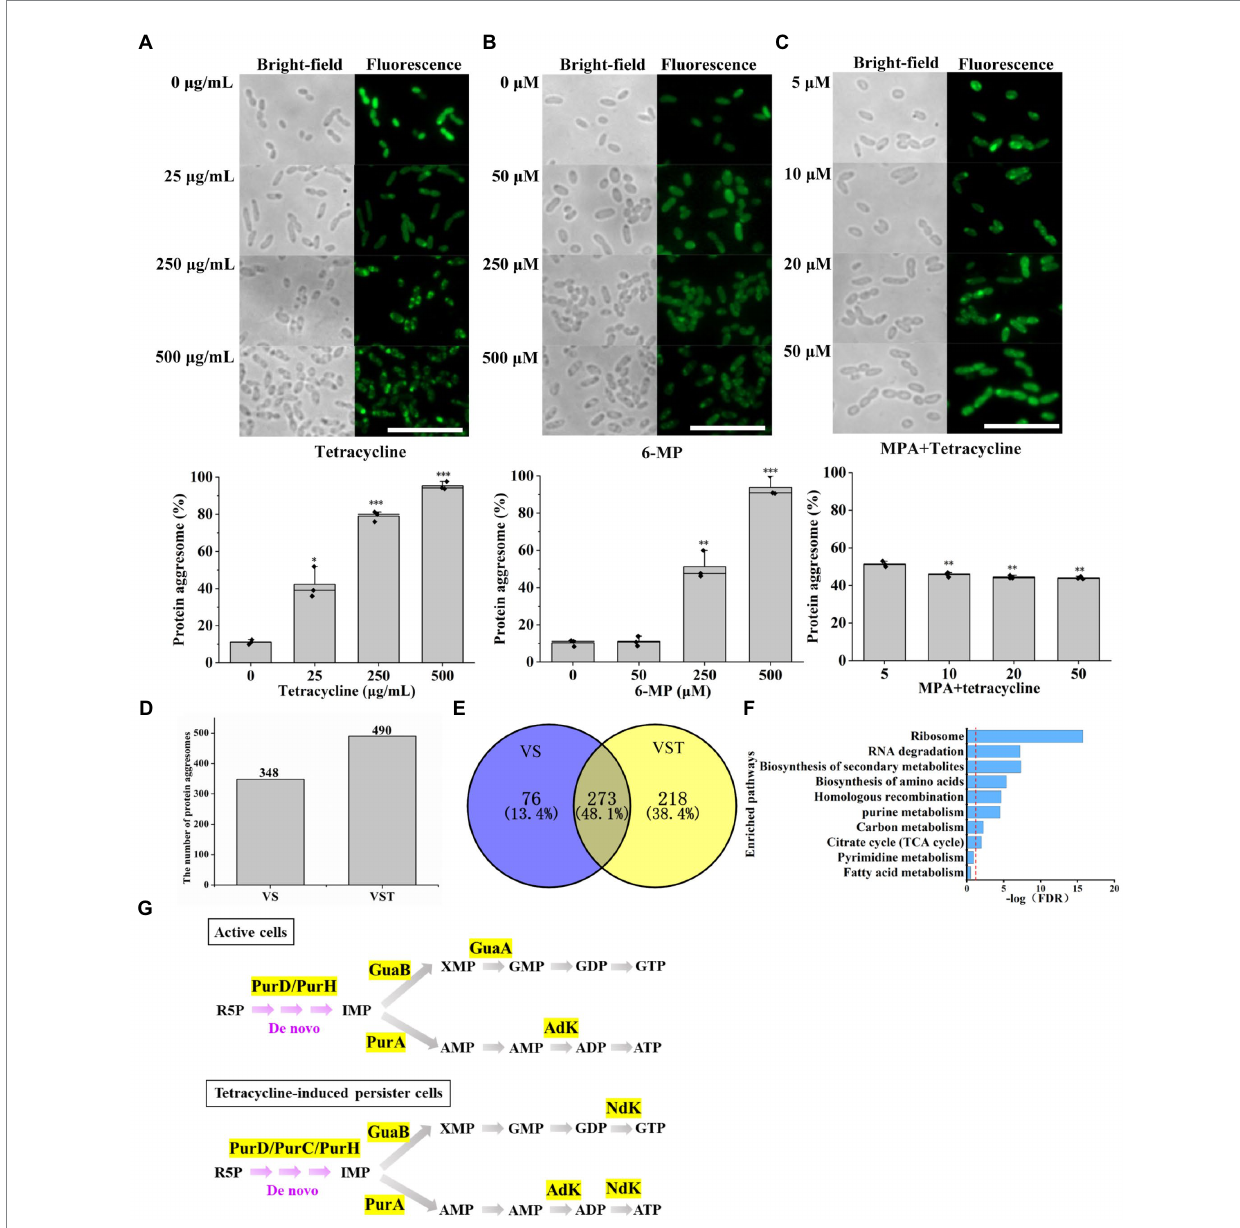
FIGURE 3 Decreased purine metabolism accompanies protein aggresome formation. Bright-field and fluorescence images showing that protein aggresomes are induced by different concentrations of tetracycline (A) or 6-MP (B) . And percentage of cells with protein aggresome after different concentrations of tetracycline treatment or 6-MP. On contrast, MPA exposure (C) significantly depressed the protein aggresome intensity. Protein aggresome from and tetracycline-induced persister cell and active cells were characterized by mass-spectrometric analysis (D) . (E) Venn diagram showing the insoluble protein overlap in active cells and tetracycline-induced persister cells. Further KEGG analysis revealed that 273 common proteins were involved in several important biological processes, in which purine metabolism related proteins were showed in (F) . (G) Purine metabolism-related proteins were found in protein aggresomes of tetracycline-induced persister cells and active cells. The scale bar of the figure was 10 μ M. The bars indicated the mean of percentage of cells with protein aggresome in cell of different treatment at least three independent experiments; standard deviation indicated STDEV. (* p value < 0.05; ** p value < 0.01; *** p value < 0.001). The microscopy settings were the same across all the